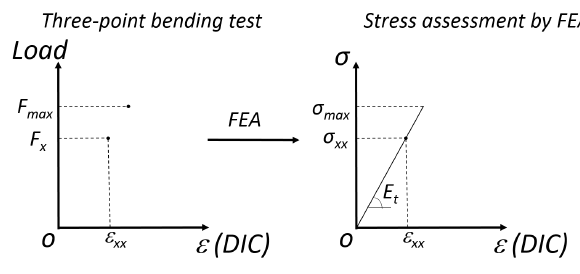
Figure 6. Method of the determination of elastic modulus and of the maximum stress values σ . max